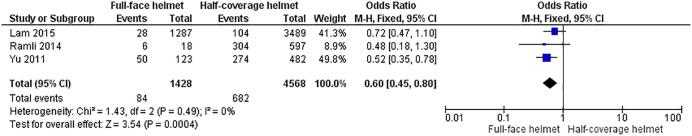
Comparison of full-face helmets and half-coverage helmets with regard to head and cervical outcomes in motorcyclists who had road accidents.